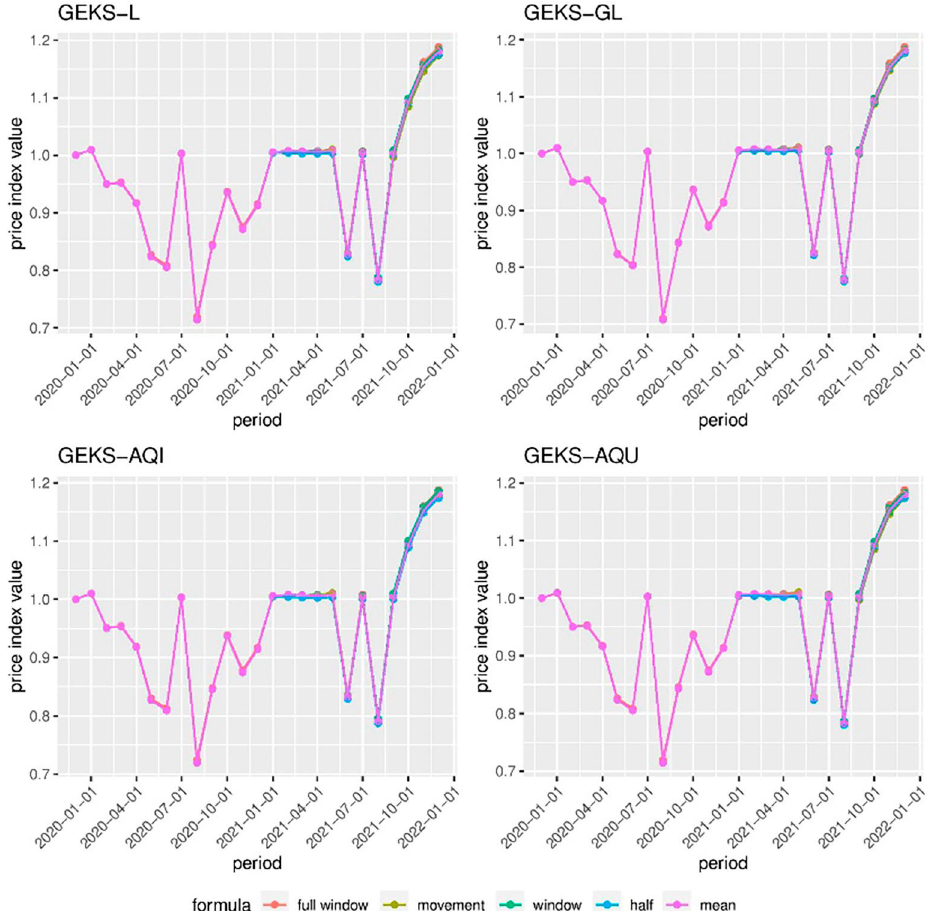
Figure A2. Comparison of G IDT indices (splicing methods vs full time indices) for sugar